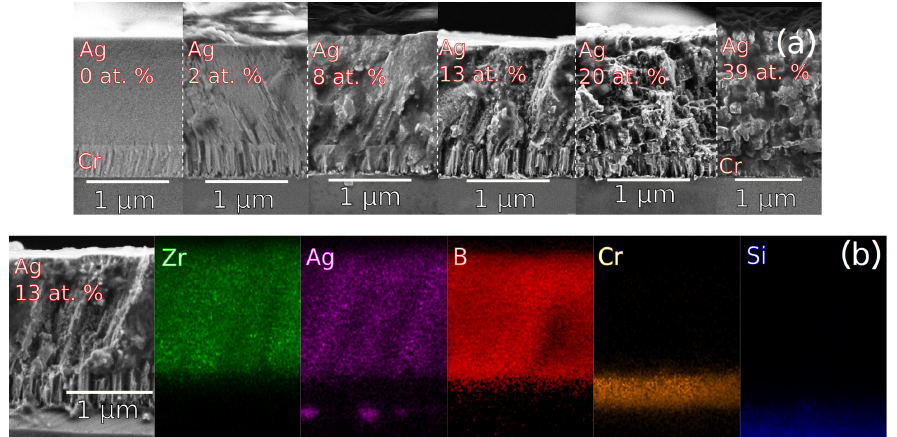
Figure 2. ( a ) Cross-sectional micrographs of ZrB 2+ ∆ and Zr 1 − x Ag x B 2+ ∆ films and ( b ) Zr 0.65 Ag 0.35 B 1.67 (13 at.% Ag) cross-sectional micrograph with corresponding EDS map of elemental distribution.